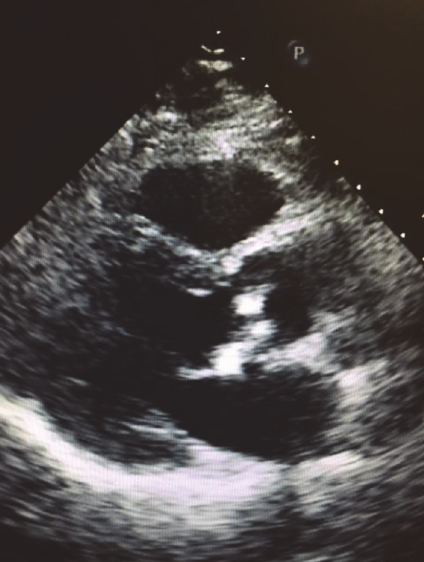
Figure 2: Hallux valgus.